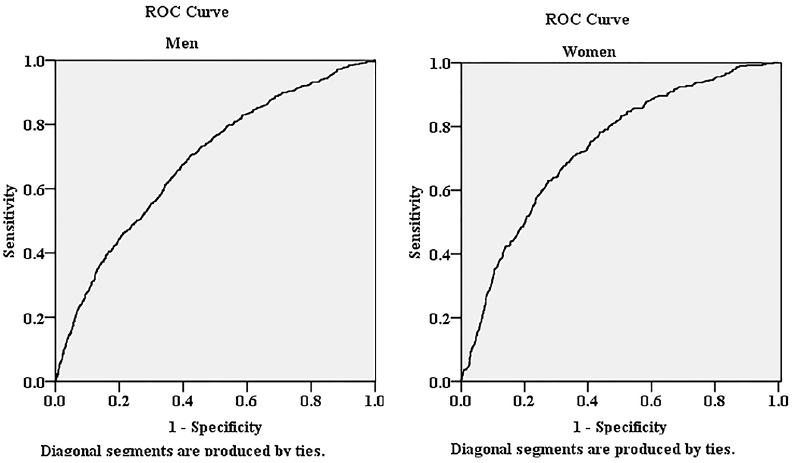
Figure 3. The area under the receiver operating characteristic (ROC) curves of AIP for the presence of HUA in both sexes.